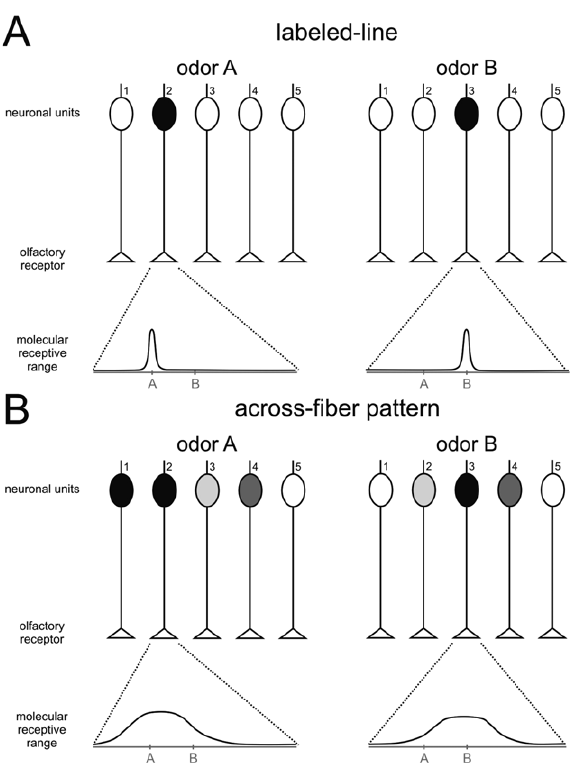
Figure 1. Schematic representation of two theories of odor